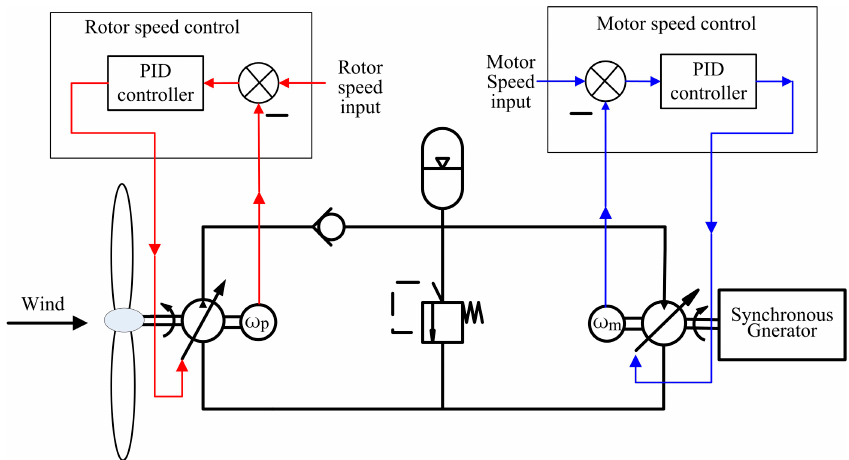
Figure 5. Speed control diagram of the closed hydraulic wind turbine with energy storage system.